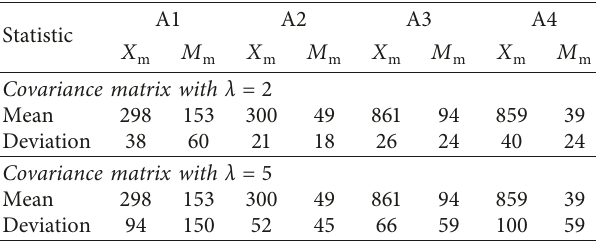
Table 4: Mean and standard deviation of priors π M X π PR m ) ( m (mm) and (